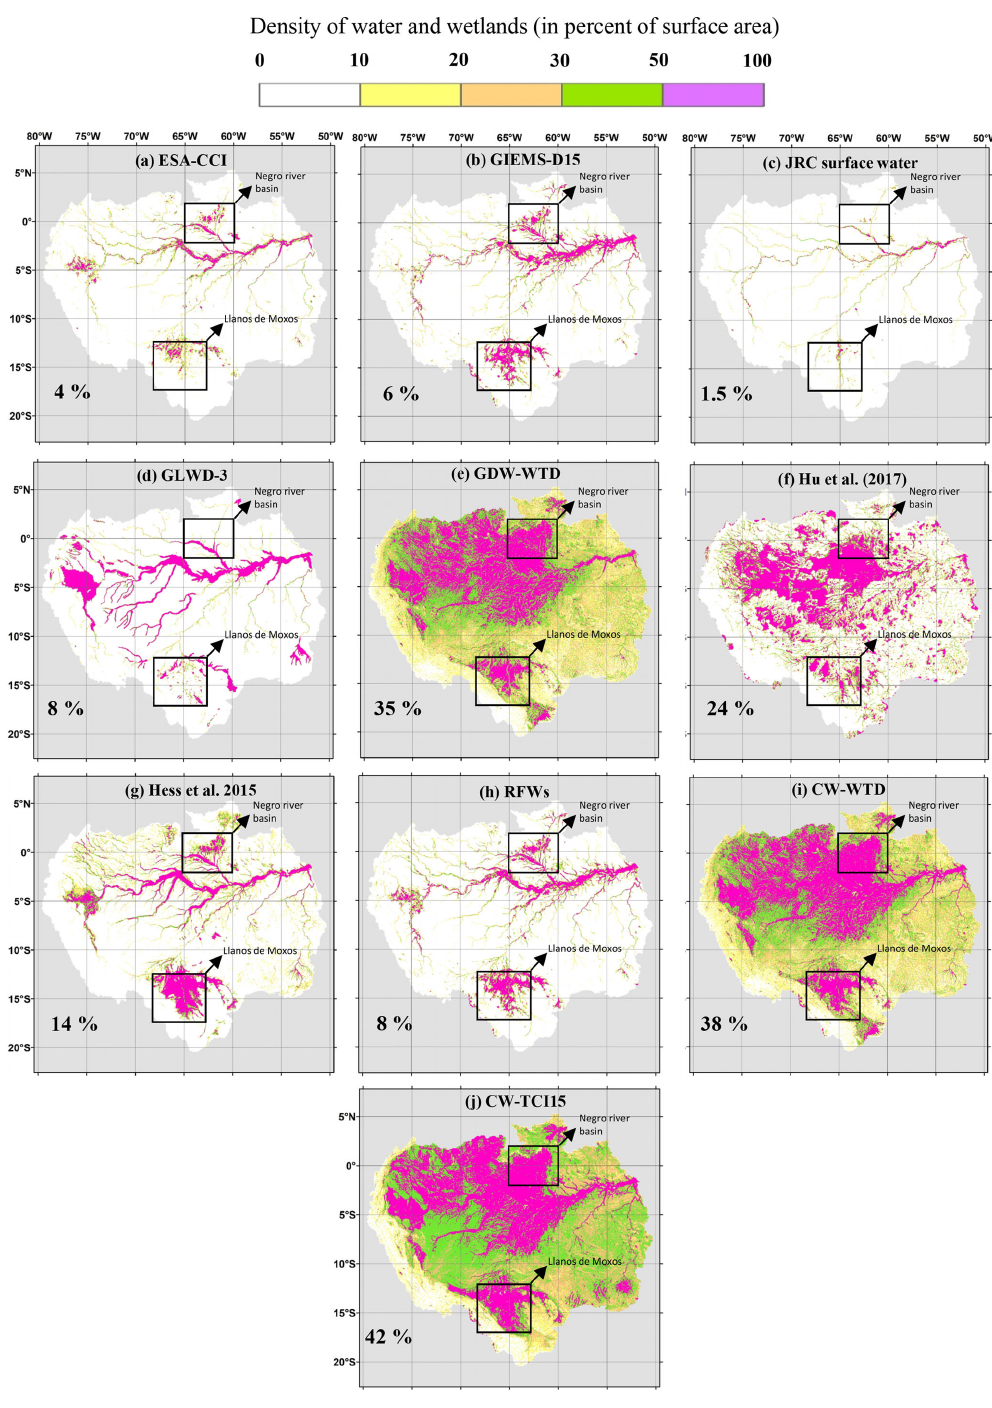
Figure 6. Maps of the Amazon River basin wetlands according to different water and wetland datasets: (a–c) components of RFW, (d– g) evaluation datasets and (h–j) datasets generated in this study. The panels also give the mean areal wetland fraction of each dataset in the study area (using the mean fraction of each fractional wetland class of GLWD-3; cf. Sect. 2.5.1). The bounds of the basin are taken from Hess et al.